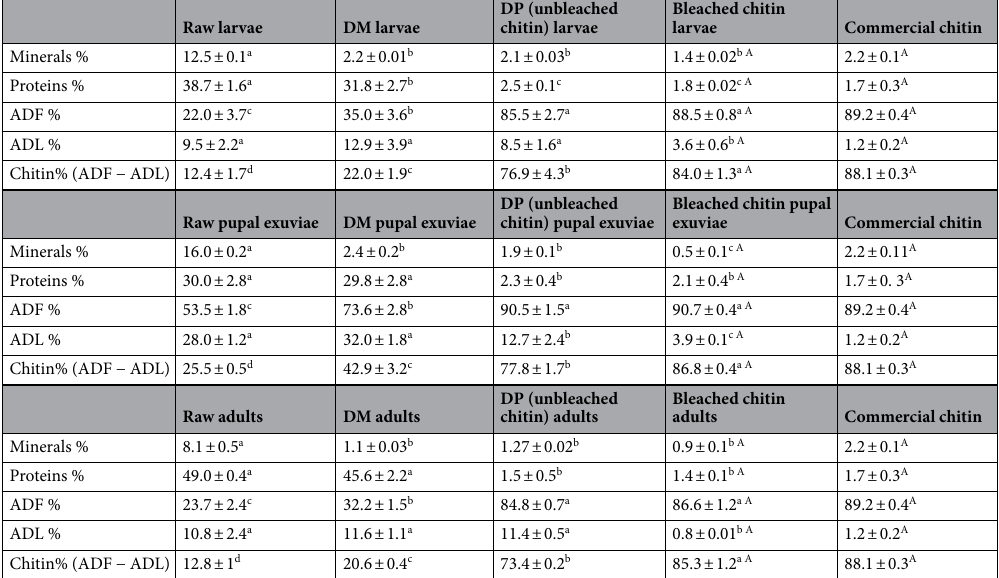
Table 3. Composition of insect samples, in terms of minerals, proteins and fibres, before and after each step of the chitin extraction process, in comparison with commercial chitin derived from shrimp shells. Data are expressed as mean ± standard deviation. Different letters in a row indicate significant differences among the different insect samples in the percentage of each component ( p < 0.05) (data analyzed with one-way ANOVA and Tuckey post-hoc test). Same capital letters in a row, indicate no significant differences between chitin extracted from H. illucens and the commercial one, for each component (data analyzed with Chi-square test with Yates’